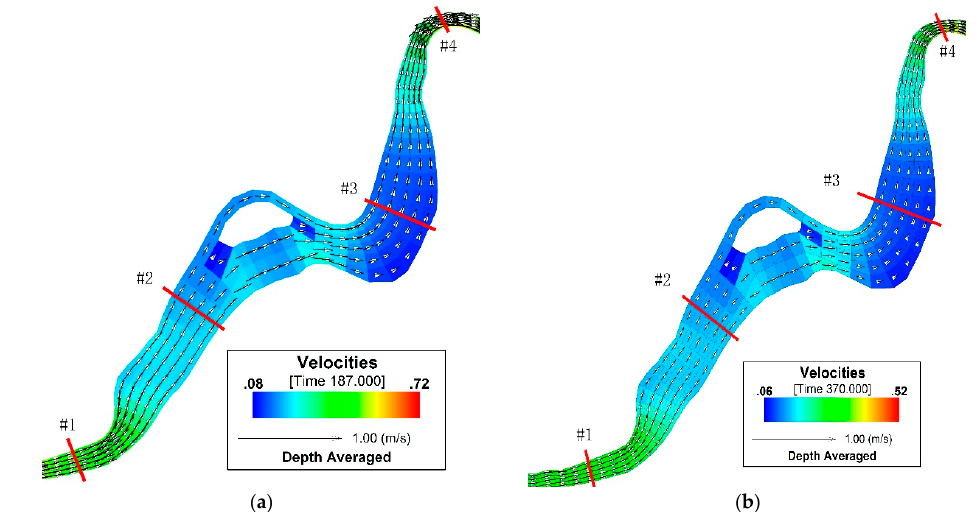
Figure 5. Schematic diagram for flow field in the urban section of Mudan River trunk stream. ( a ) open-water period; ( b ) ice-covered period.